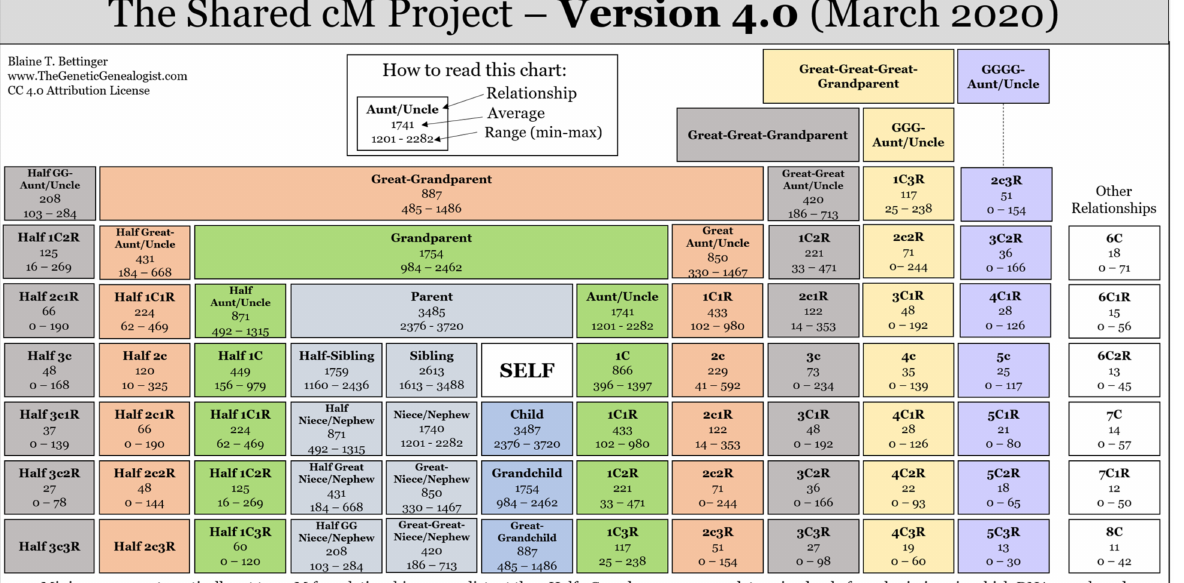
Figure 2. Shared cM Relationship Chart with the average and range (min-max) shared cMs for each relationship type. Image credit—Blaine T. Bettinger